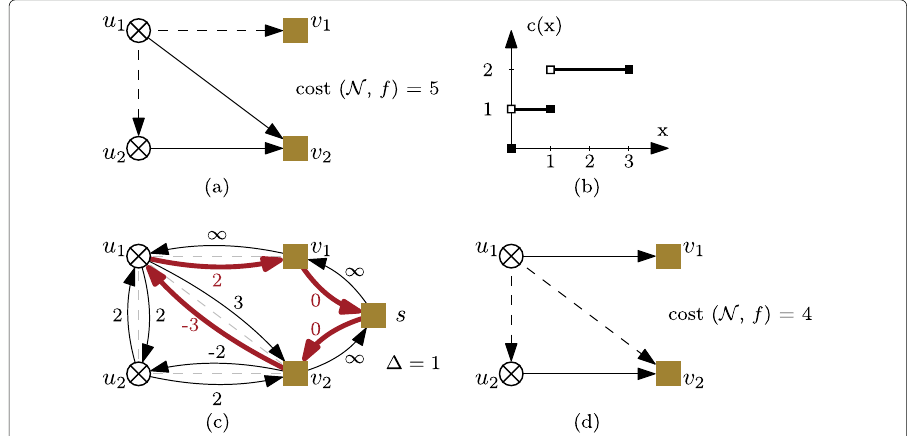
Fig. 2 Canceling a negative cycle. ( a ) A feasible flow f on the network N is shown. Turbines are represented by circles with a cross and substations by filled squares. All substations have capacity 2. The edge ( u 1 , v 2 ) has length 3, all others have length 2. Dashed lines represent edges without flow, regular edges have a flow of 1. ( b ) The cost function c induced by the cable types ( 0,0 ) , ( 1,1 ) , ( 3,2 ) , and ( ∞ , ∞ ) . ( c ) The residual graph R based on f and (cid:3) = 1. The fat red edges mark a negative cycle. ( d ) The new flow after canceling the negative